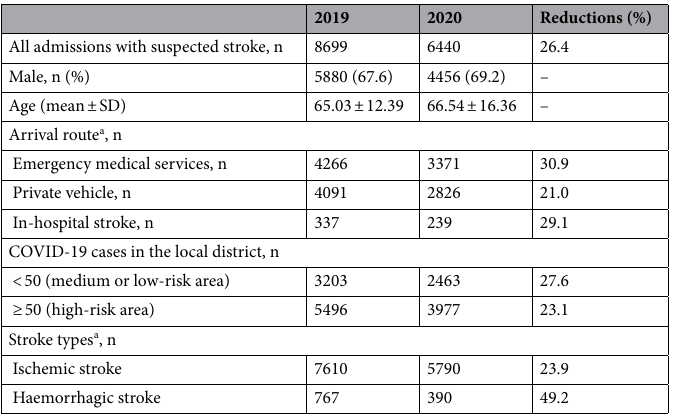
Table 1. Effects of the pandemic on the number of admissions in Beijing. a The difference in distributions between two periods was statistically significant ( P < 0.05).